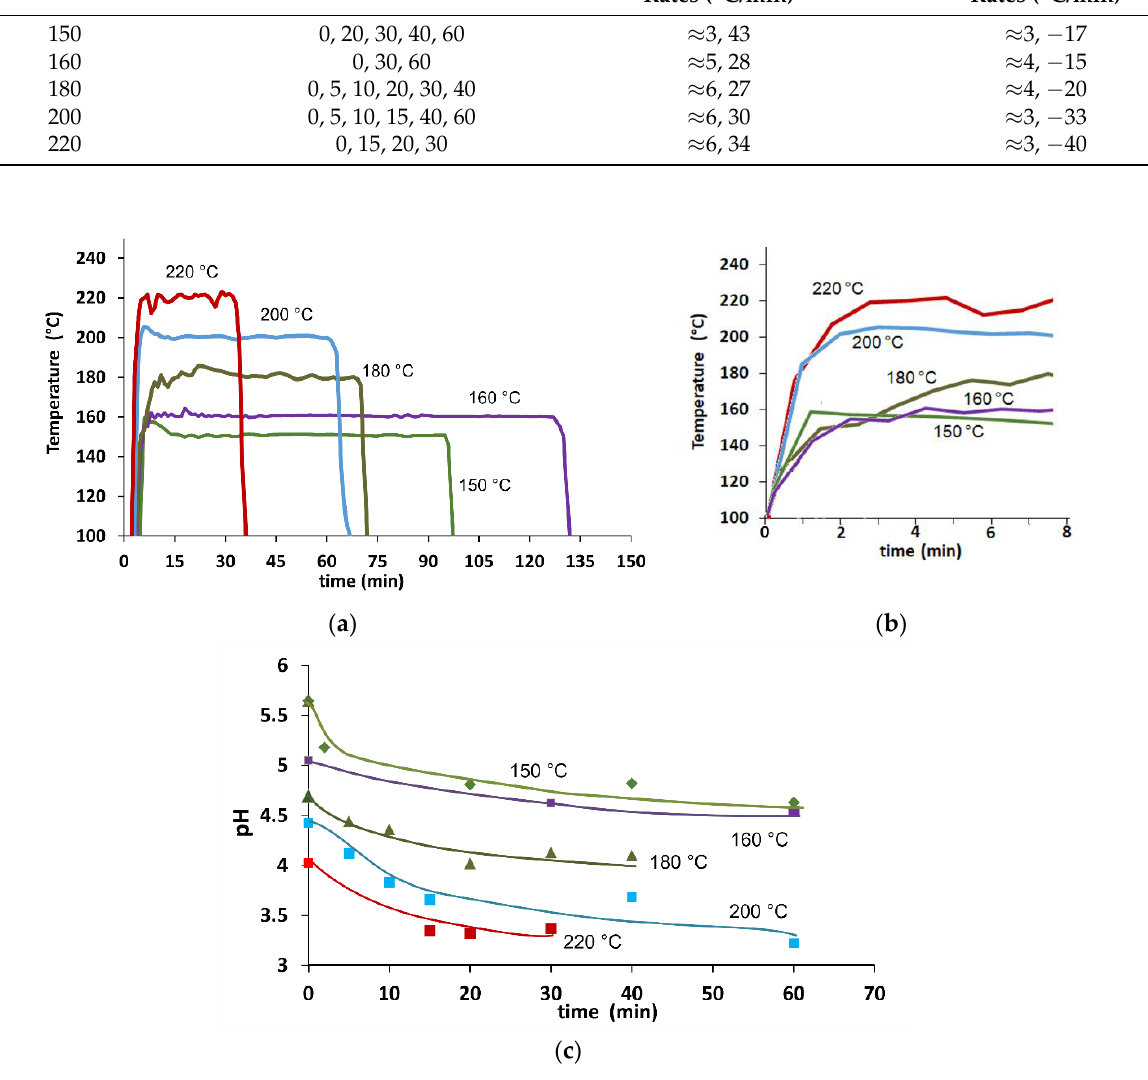
Figure 1. ( a ) Typical behavior of reaction temperature and ( b ) heating ramps in HP experiments of WS at the longest reaction times. ( c ) Mean pH profiles in HP experiments of WS as a function of time. The continuous lines are the tendencies of the experimental pH values.